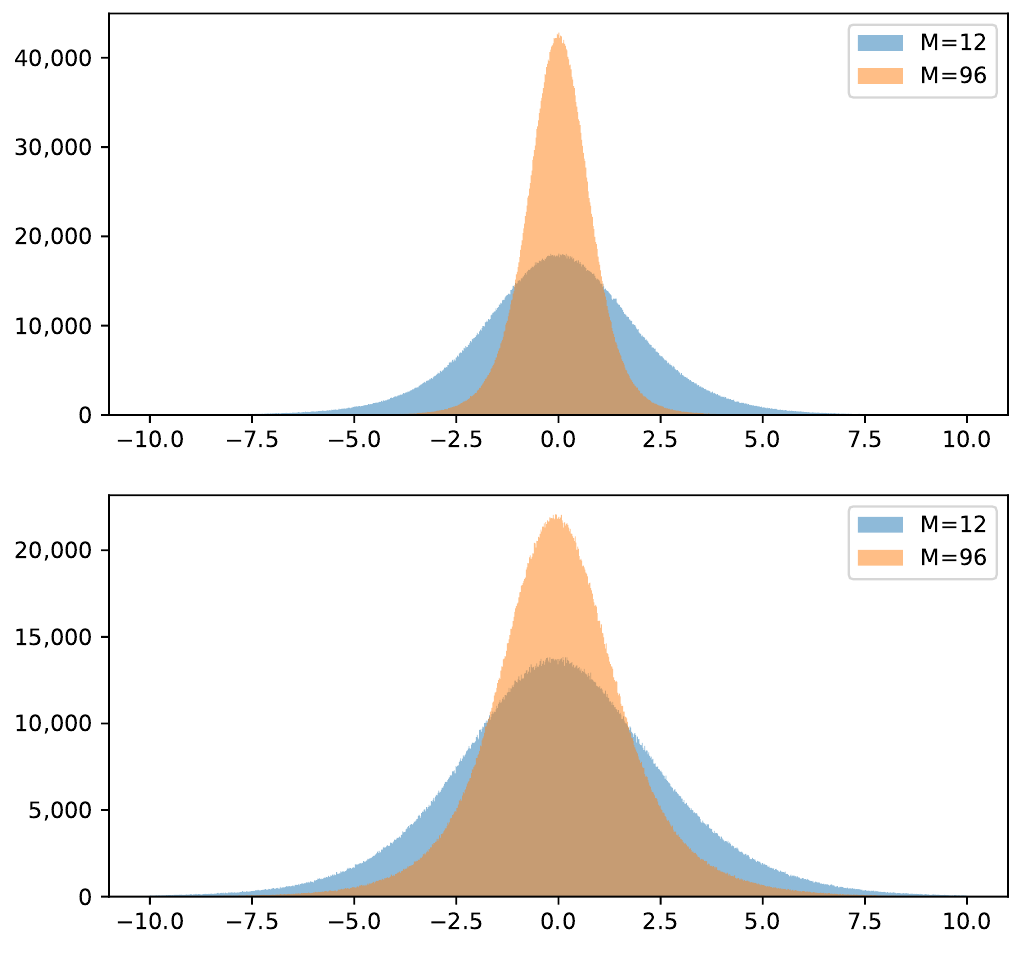
Figure 1. Total hedging errors for s 0 = 100, M ∈ { 12,96 } , d = 5 (top) and d = 10 (bottom) along 4,096,000 sample paths of ( Y m ) NM . The values of the parameters r , δ , σ , ρ , K , T and N were as in m = 0 Tables 1 and